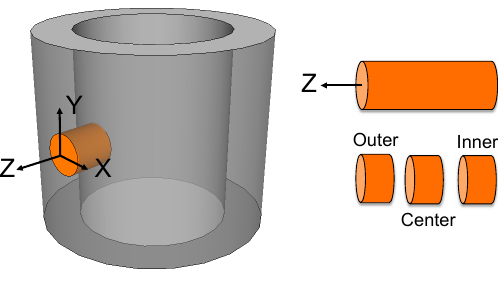
Figure 1. Reference frame of the Bi-2212 tube and sample cutting procedure.